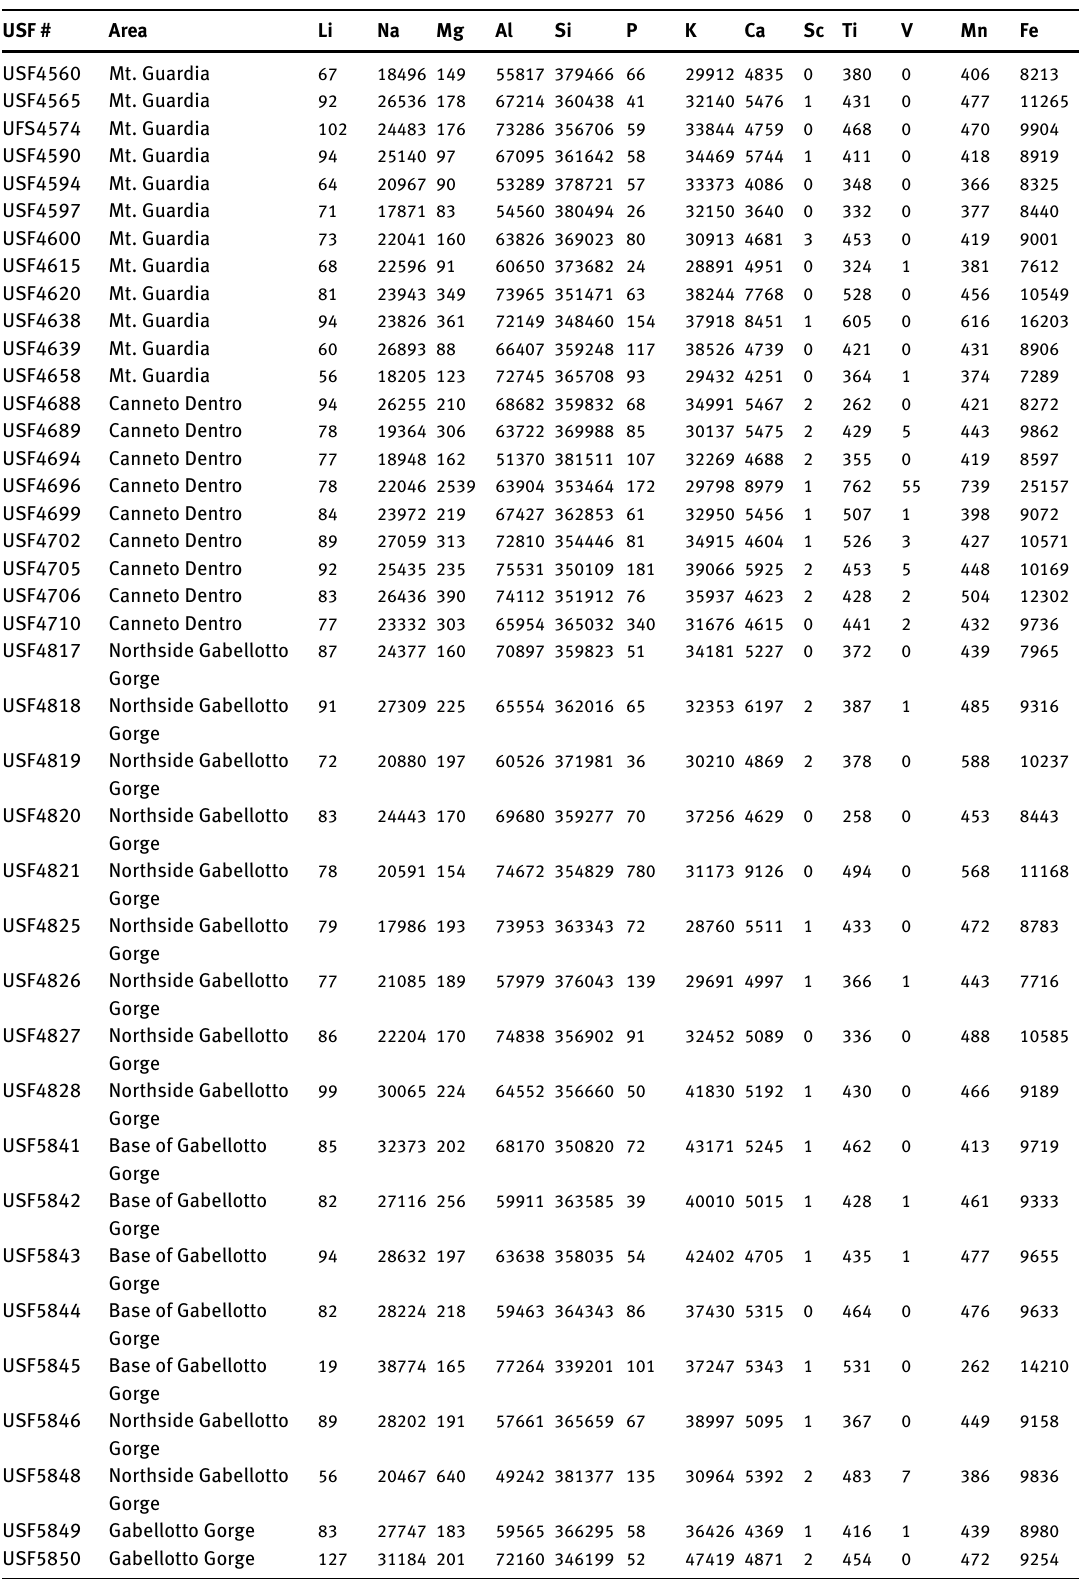
Table 2 . LA-ICP-MS analyses of Lipari